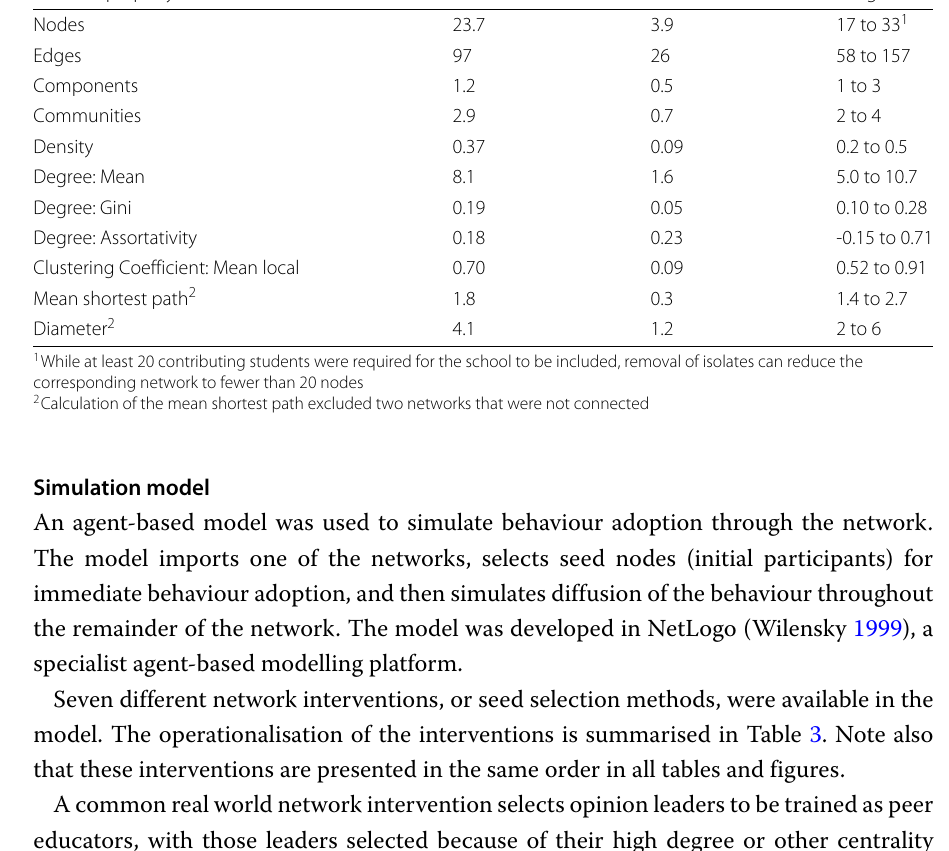
Table 1 Properties of 17 networks used in simulations: Summary Network property Mean SD Range Nodes Edges Components Communities